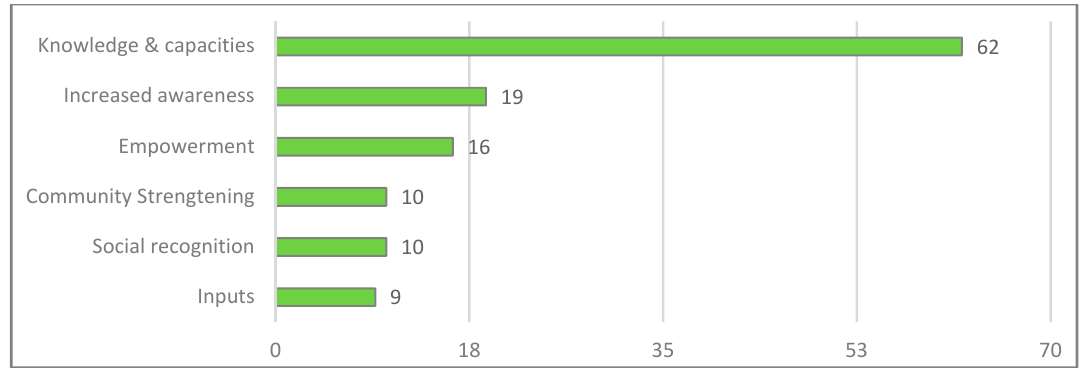
Figure 10. References to ES-unrelated social benefits in the Cartagena case study (own representation).